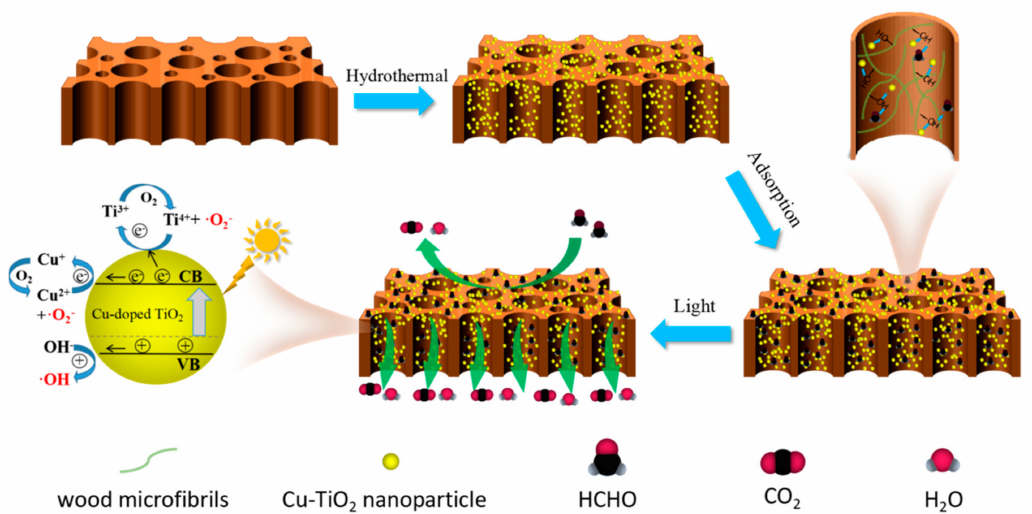
Figure 7. Schematic diagram for Cu-doped TiO 2 on wood photocatalytic degradation of